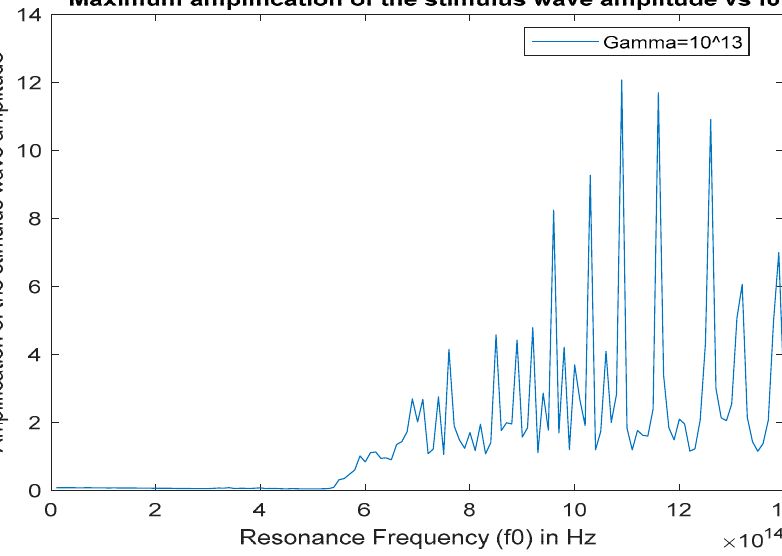
Figure 11. Maximum stimulus wave amplitude (gain factor) inside the cavity at x = 5.73 µ m for 0 < t < 30 ps, γ = 1 × 10 13 Hz, versus f 0 .